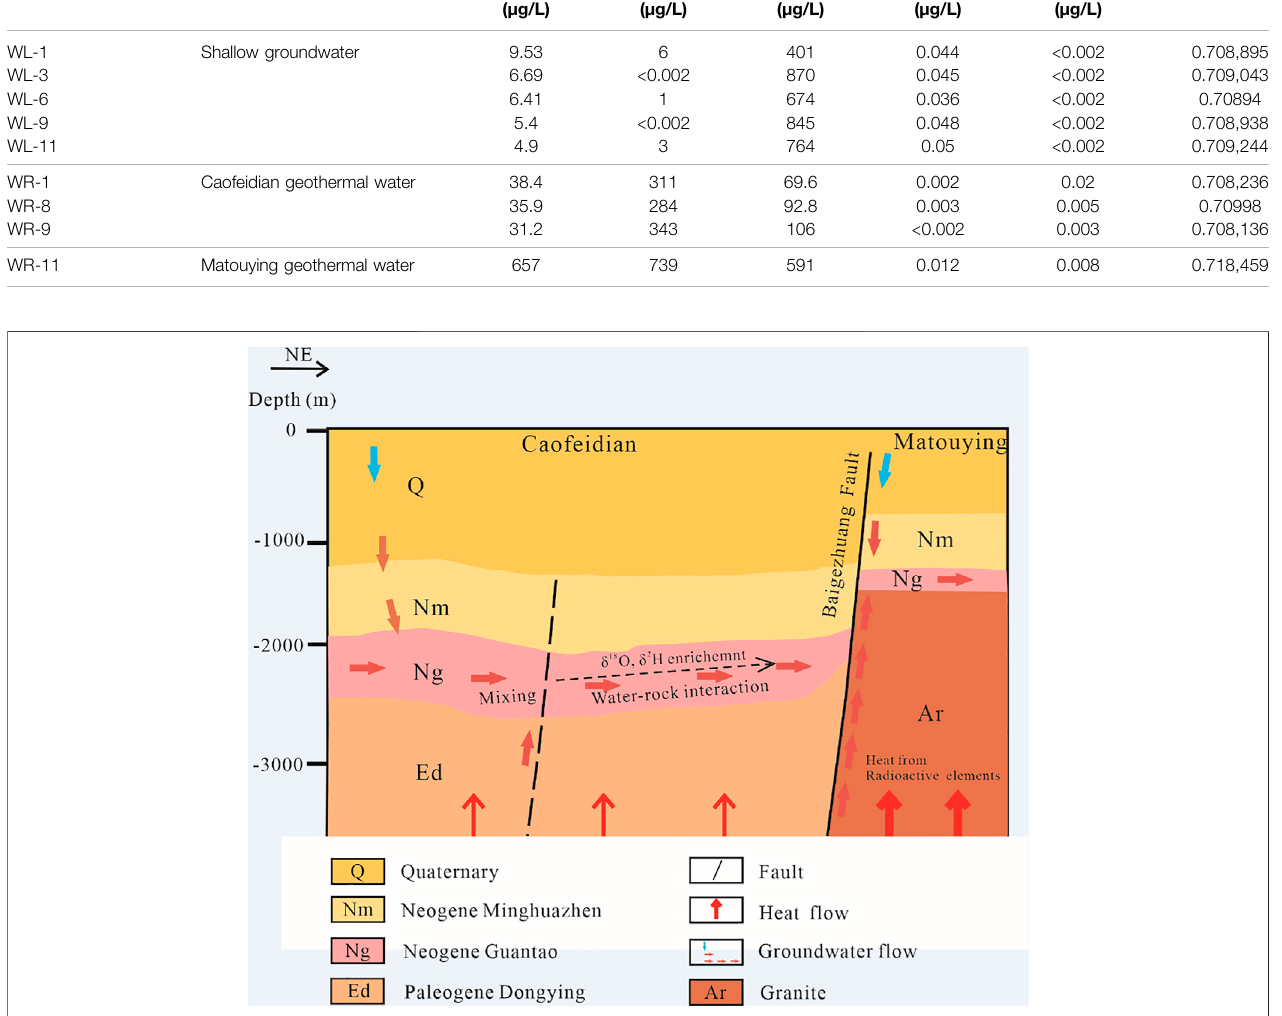
FIGURE 8 | Conceptual model of hydrothermal genesis of the Caofeidian and the Matouying geothermal reservoirs.